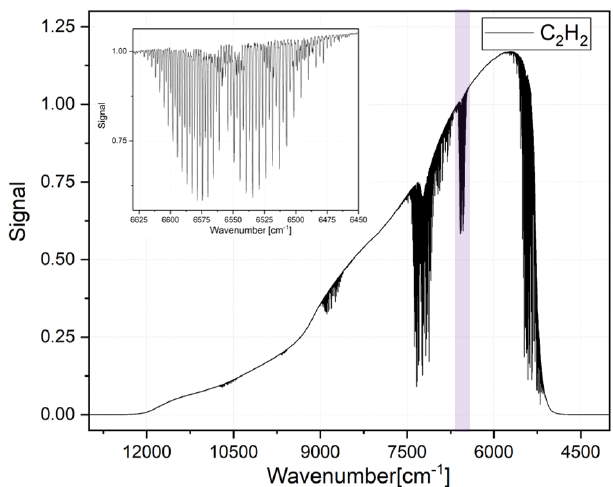
Figure 6. An open-path spectrum recorded with the C 2 H 2 cell inserted in the beam. The spectrum was recorded using COC- CON’s EM27/SUN reference spectrometer SN37. The insert shows a zoom-in of the wavenumber range used for the retrieval of ILS parameters from C 2 H 2